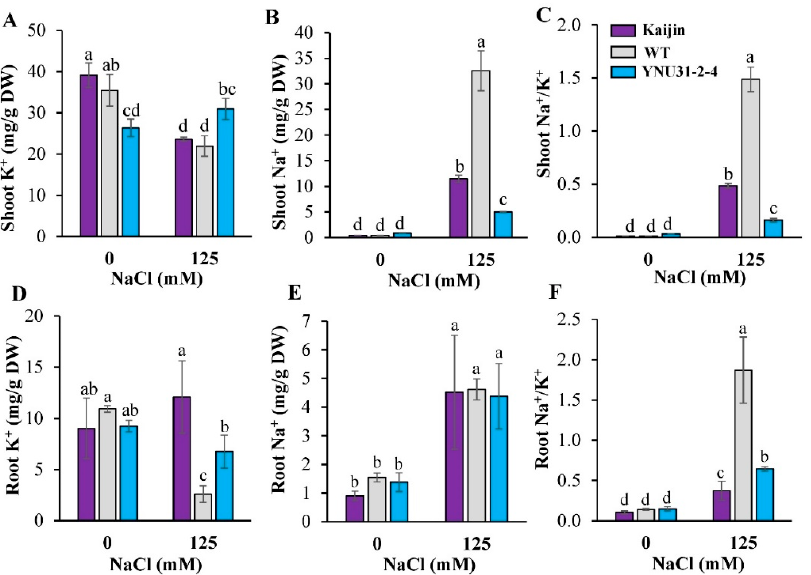
Figure 5. Na + and K + content in shoot and roots of the tested genotypes under salt stress. ( A ) Shoot K + , ( B ) shoot Na + , ( C ) shoot Na + /K + , ( D ) root K + , ( E ) root Na + , and ( F ) root Na + /K + of 20-day-old seedlings. Data are mean ± SD of three independent biological replicates. Bars with the same letter are not statistically different (Duncan’s multiple range test, p < 0.05).